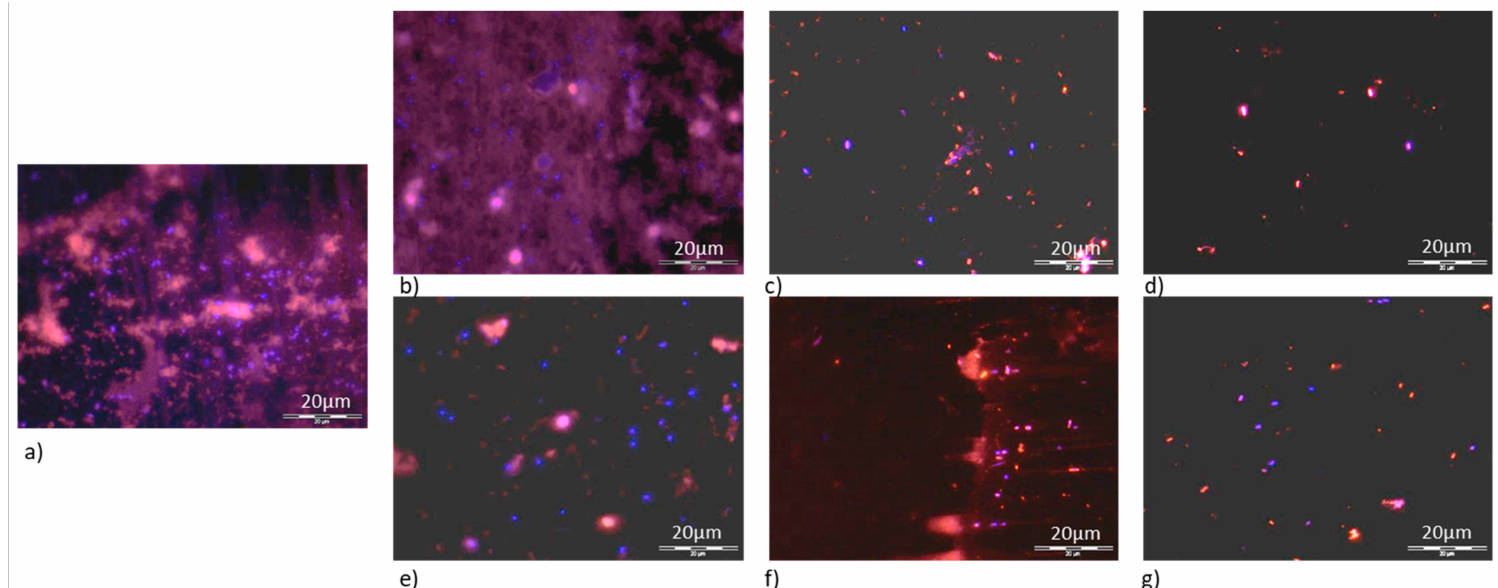
Figure 4. Meat exudate (red) and E. coli cells (blue) remaining on titanium coated fine polished stainless steel surface (TiFP) following ( a ) pre-cleaning procedure, ( b ) one wipe clean along, ( c ) five wipe cleans along, ( d ) ten wipe cleans along and ( e ) one wipe clean across, ( f ) five wipe cleans across and ( g ) ten wipe cleans across. Scale bar: 20 µ m. Differential staining was conducted to visualise bacterial cells and the meat exudate on the surfaces and an example of the images on the TiFP surfaces is demonstrated (Figure 5). Prior to the cleaning procedure, the meat exudate (red) and bacterial cells (blue) can be observed in abundance (Figure 5a). The concentration of organic material and E. coli declined as the number of wipe cleans increased, both in the direction of, and perpendicular to the linear surface features (Figure